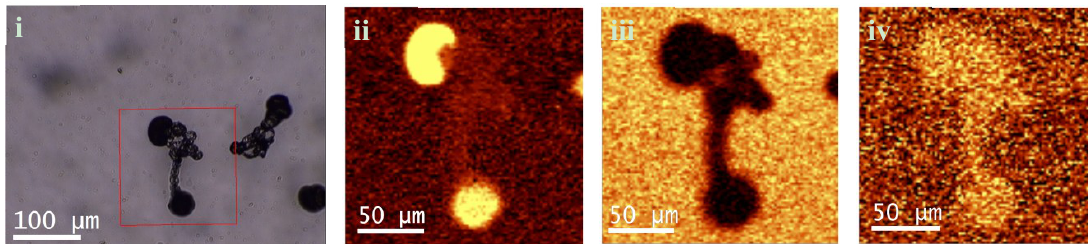
Figure 8. ( i ) Optical image of a Ba biomorph. ( ii ) Mapping of the 1062 cm −1 shift for BaCO 3 ( iii ) Mapping of the substrate glass tracked between 515 and 620 cm −1 . ( iii ) Amorphous SiO 2 , tracked between 440 and 520 cm −1 .